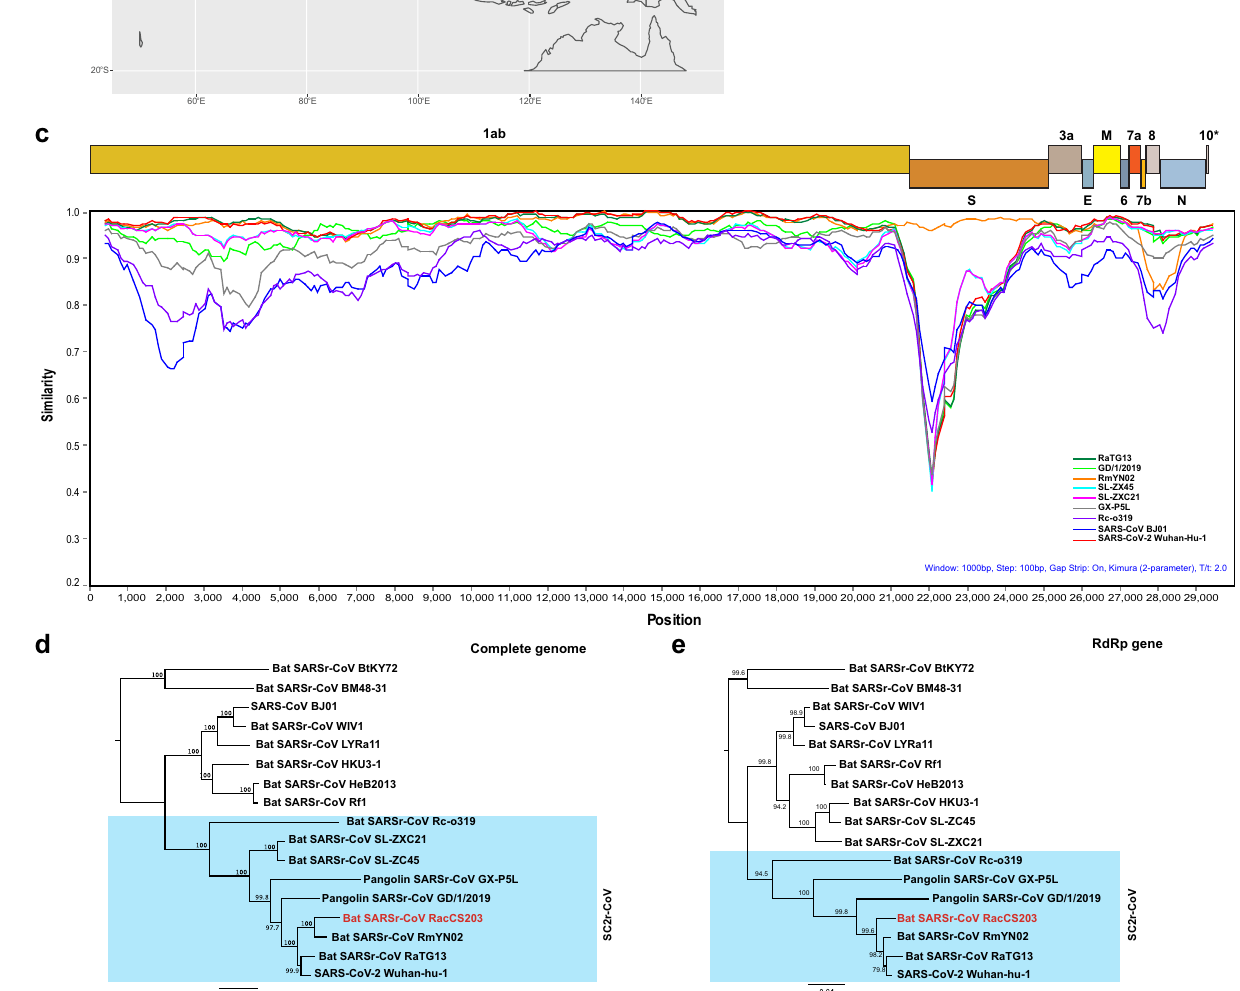
Fig. 1 Molecular detection of a SC2r-CoV in bats in Thailand. a Map of Asia illustrating the SC2r-CoVs detected in this region to date. b The Acuminatus horseshoe bats from which the SC2r-CoV was detected. Photo taken by the Thai research team of this study group. c Similarity plot (SimPlot) of whole- genome sequences of 10 SARSr-CoVs using the RacCS203 as a reference genome. d Phylogenetic tree based on whole-genome sequences. e Phylogenetic tree based on the RdRp gene sequences. The trees in d and e were generated using PhyML with general-time-reversible (GTR) substitution model and 1000 bootstrap replicates. Numbers (>70) above or below the branches are percentage bootstrap values for the associated nodes. The scale bar represents the number of substitutions per site. RacCS203 was highlighted in